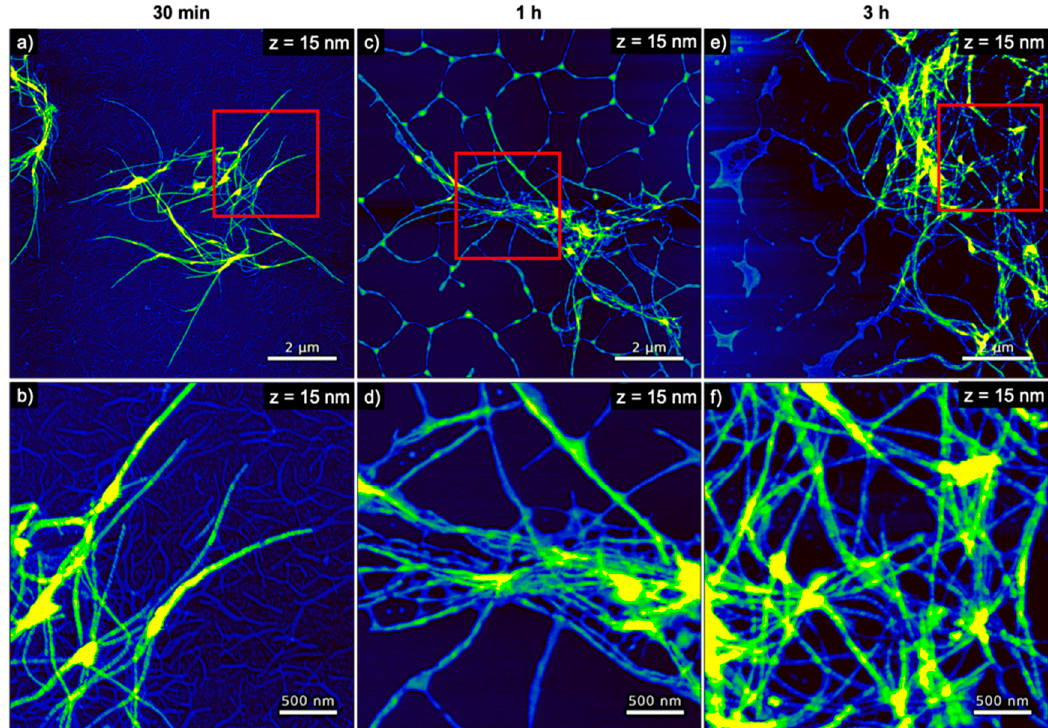
Figure 7. AFM images of hIAPP incubated with DNA origami 6HBs for ( a , b ) 30 min, ( c , d ) 1 h, and ( e , f ) 3 h. The images in ( b , d , f ) represent zooms of the regions indicated in the respective images in ( a , c , e ). The ranges of the z-scales are given in the individual images.